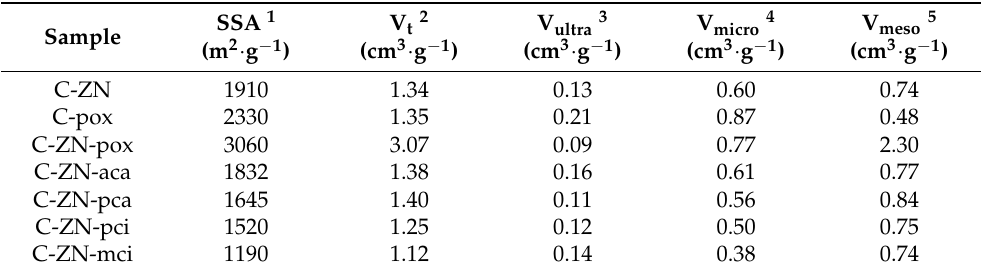
Table 2. Structural parameters calculated from low-temperature ( − 196 ◦ C) nitrogen adsorption data for all samples